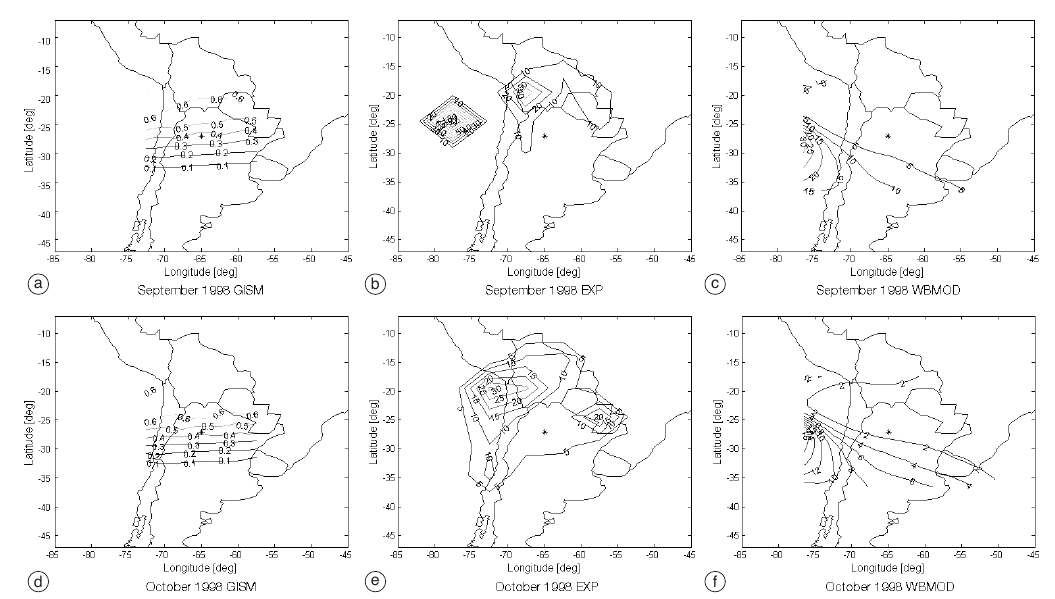
Fig. 3a-f. Percentages of occurrence of S 4 > 0.5 for experimental data and WBMOD and predicted S 4 values by GISM are shown at 22 LT (September and October